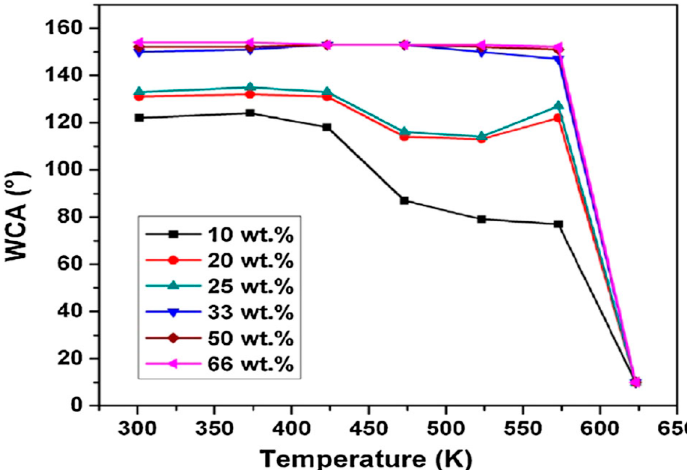
Figure 11. Variation of the water contact angle with temperature in the coatings (Polyvinylidene fluoride and multiwall carbon nanotube [109].